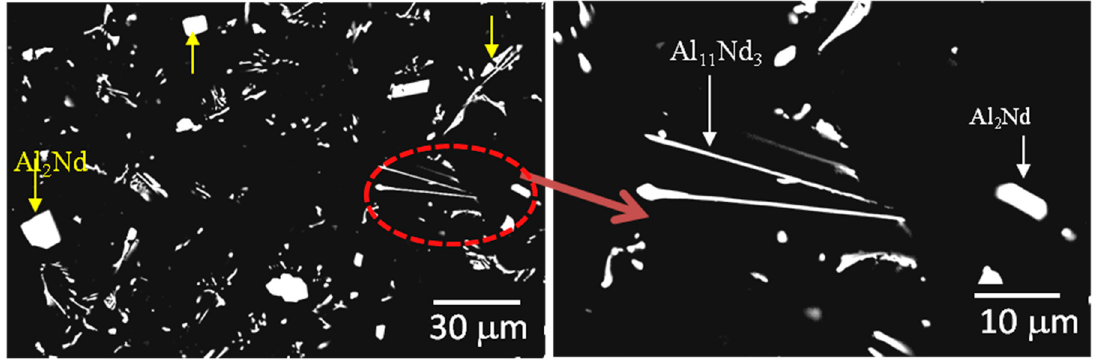
Figure 4. FESEM micrograph of Mg-4Al-4Nd at higher magnifications.